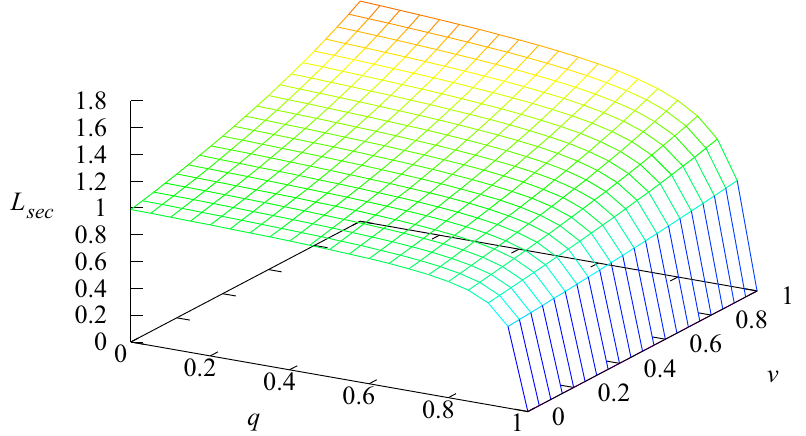
Figure 8. Dependence of the average number of customers with the secondary server L sec on the parameters q and ν